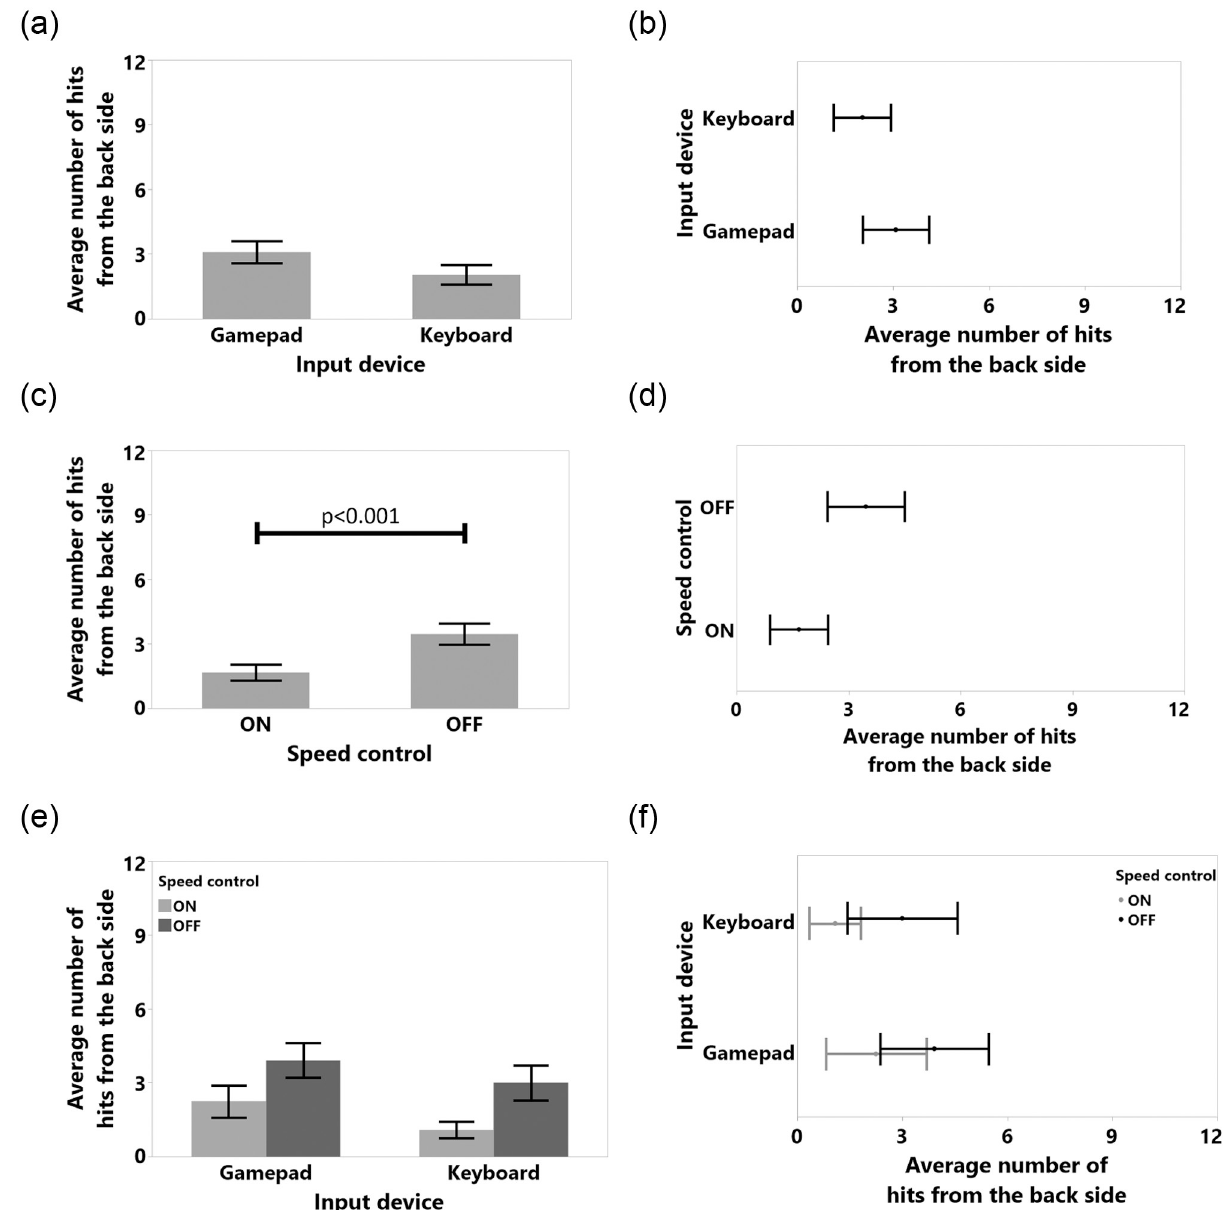
Fig 11. Means and standard error of means for number of hits from the front side for (a) input device, (c) speed control, (e) input device and speed control interaction. Means and %95 confidence intervals for number of hits from the front side for (b) input device, (d) speed control, (f) input device and speed control